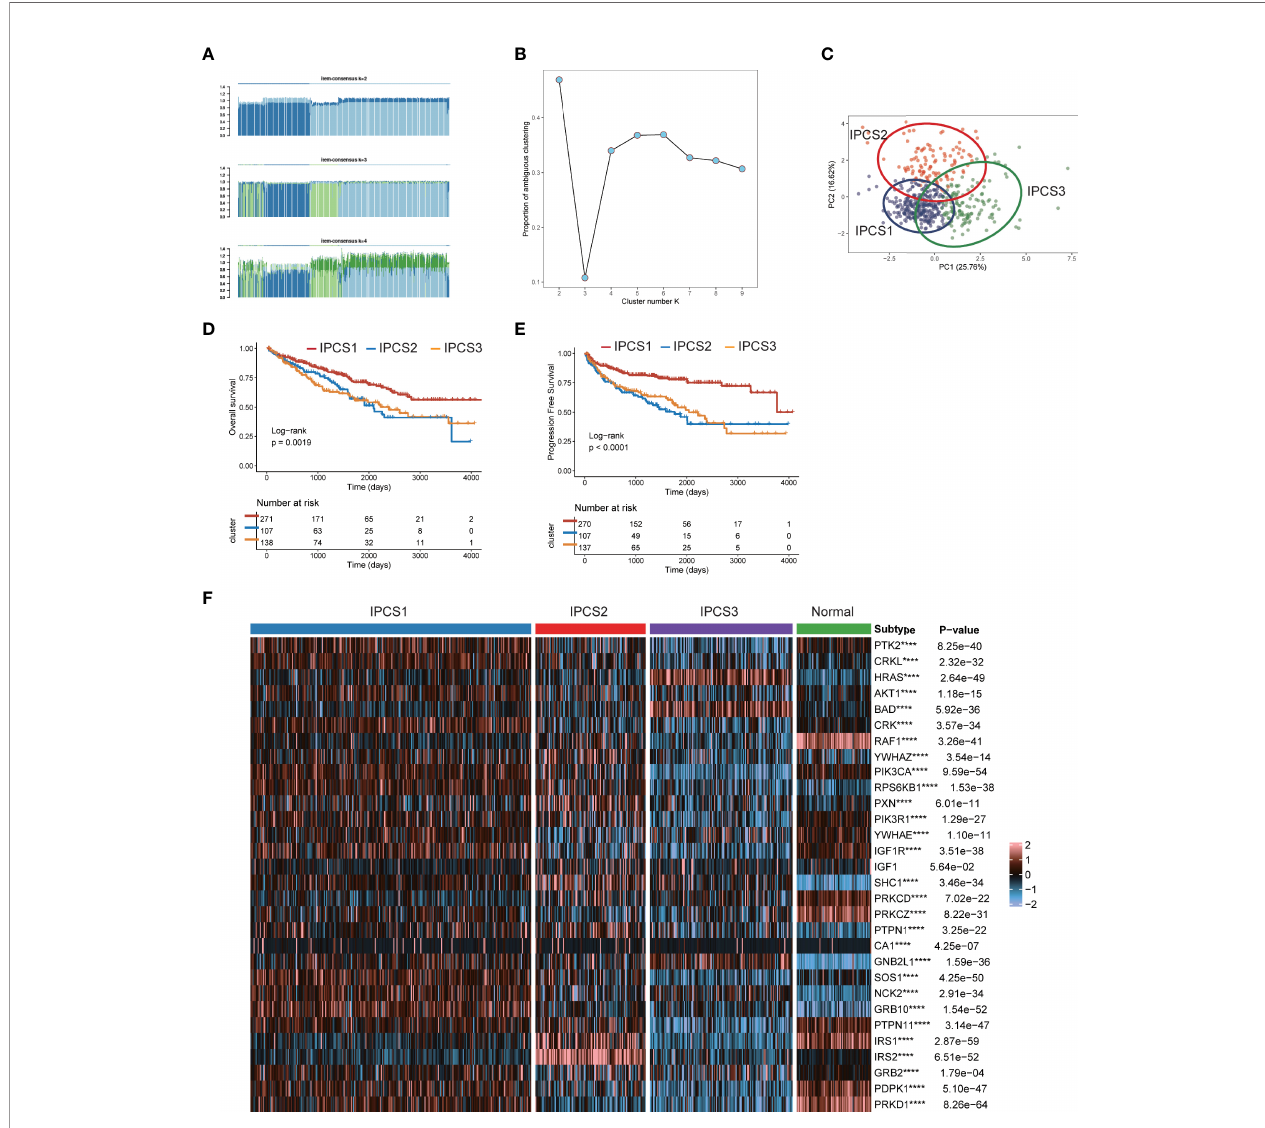
FIGURE 2 | Screen of three clusters for IGF regulator genes in ccRCC. (A) Consensus matrix of samples in TCGA-ccRCC for k = 2, 3, or 4. (B) The cluster numbers are determined by the lowest proportion of ambiguous clustering. (C) The principal component plot is based on IGF regulator genes. (D, E) Survival analysis for overall survival (OS) and progression-free survival (PFS) among the three subtypes of TCGA-ccRCC. (F) The expression pro fi les of IGF regulator genes among the three subtypes and normal tissues. ****p <